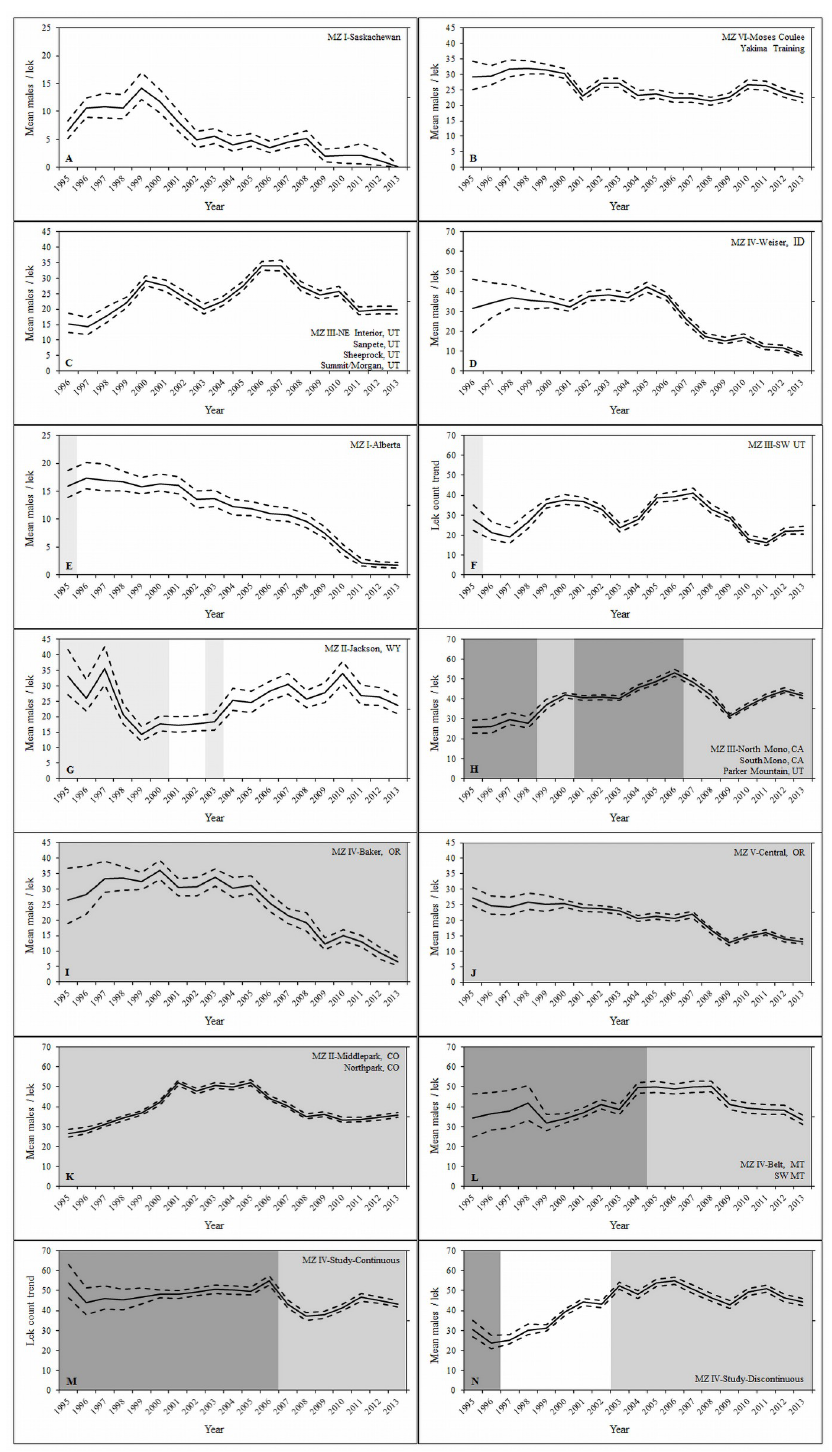
Fig 2. Predicted lek counts (mean males/lek) during 1995–2013 from top open population N-mixture models using empirical Bayes methods. Annual predictions were stratified by regulation history and sage-grouse Management Zone (MZ). Light gray indicates human harvest occurred but no harvest exposure effect was detected, medium gray indicates that a harvest exposure variable was influential on instantaneous growth rate ( r ) with harvest exposure relatively low, and dark gray indicates a harvest exposure variable was influential on instantaneous growth